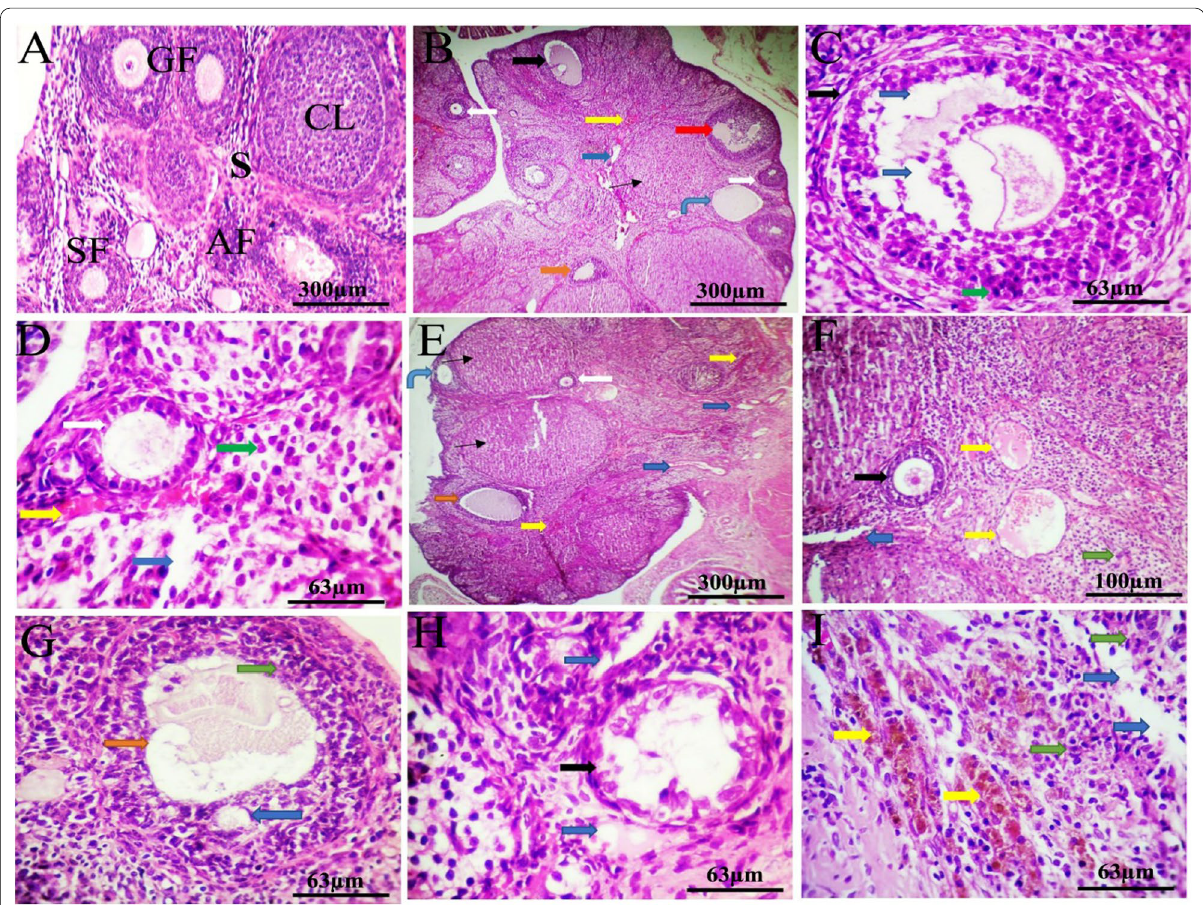
Fig. 3 Photomicrographs of an ovarian section (H&E stain, n 3 from each group). Control ( A ): normal atretic follicle (AF), Graafian follicle (GF), = stroma (S), corpus luteum (CL), and secondary follicles (SF). Low dose ( B – D ): degenerative follicles, the primary follicle (white arrow), the tertiary follicle (red arrow), degenerated secondary follicle (black arrow), vacuolation (blue arrow), cyst (curved blue arrow), corpus luteum (thin arrow), dilated vessels in the ovarian medulla and hemorrhage (yellow arrow), and atretic follicle (orange arrow), apoptotic cells having deep acidophilic cytoplasm with pyknotic nuclei (green arrow), and abnormal spaces within the stroma (vacuolation) (blue arrow). D Degenerated granulosa cells (blue arrows), pyknosis (green arrow), and a slight degeneration in ovarian stromal cells or theca (blue arrow). High dose ( E – I ): degenerated corpus luteum (thin black arrow), the primary follicle (white arrow), the atretic follicle (orange arrow), follicular cysts (bent blue arrow), congested blood vessels (yellow arrow), and vacuolation in stromal cells (blue arrow), degenerated granulosa cells (black arrow), apoptotic cells having deep acidophilic cytoplasm with pyknotic nuclei (green